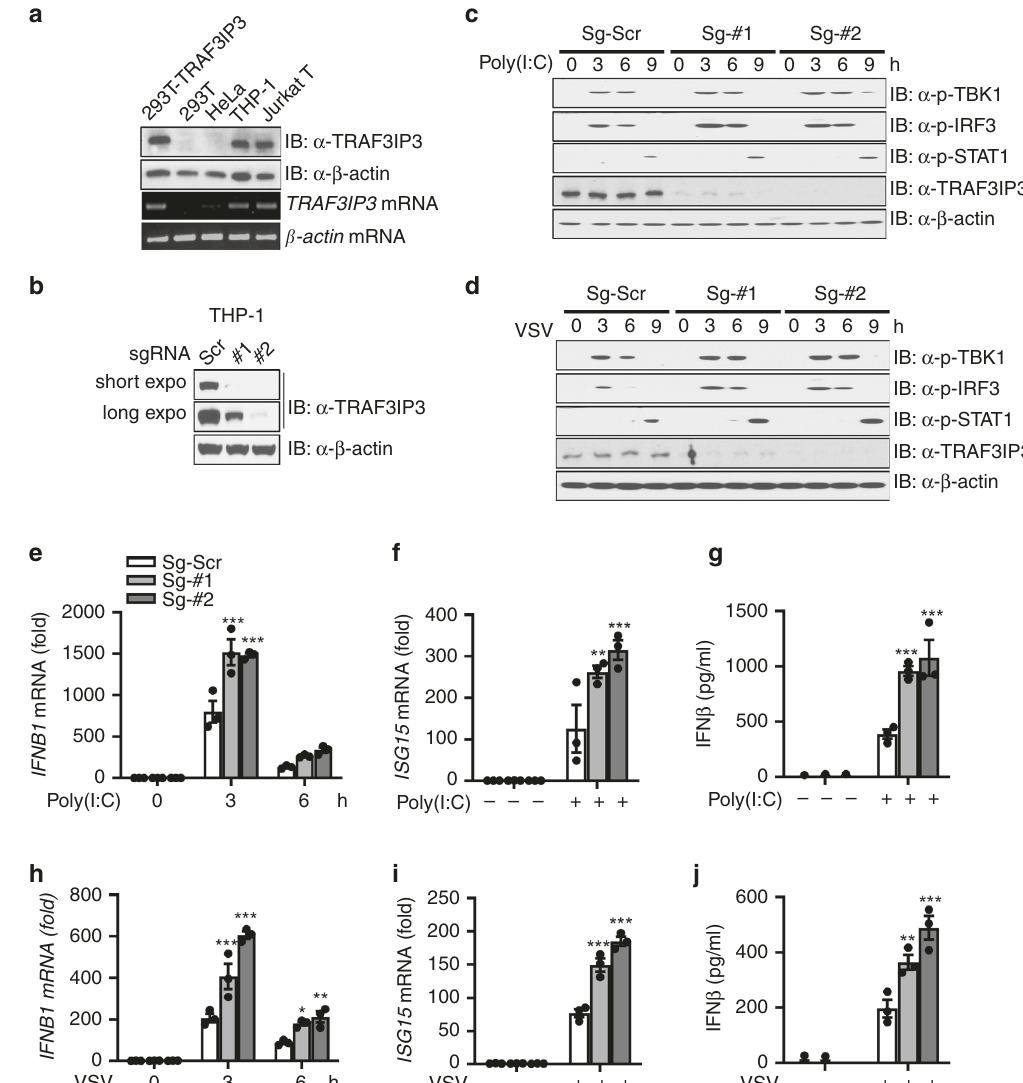
Fig. 2 CRISPR/Cas9 knockout of TRAF3IP3 potentiates the type I interferon response. a Immunoblotting (top) and RT-PCR (bottom) analyses using indicated cell lines. HEK293T cells transfected with Myc-TRAF3IP3 serves as the positive control. b Immunoblotting of THP-1 cells with scramble sgRNA or sgRNA targeting TRAF3IP3 using CRISPR/Cas9. c , d Immunoblotting of THP-1 cells with scramble sgRNA or sgRNA targeting TRAF3IP3 transfected with poly(I:C) ( c ) or infected with VSV (MOI = 1) ( d ) for the indicated time. Densitometry of immunoblots in this Figure is shown in Fig. S4. e , f RT-PCR analysis and g IFN- β ELISA using THP-1 cells with scramble sgRNA or sgRNA targeting TRAF3IP3 transfected with poly(I:C). RT-PCR data were normalized to ACTB mRNA. h , i RT-PCR analysis and j IFN- β ELISA using THP-1 cells with scramble sgRNA or sgRNA targeting TRAF3IP3 infected with VSV (MOI = 1). RT-PCR data were normalized to ACTB mRNA. f , g , i and j were at 9 h post transfection or infection. sgRNA, small guide RNA. Scr, Scramble. Data are presented as mean ± SEM and are one representative of three independent experiments. e – j , two-way ANOVA followed by Holm-Sidak post hoc correction. ∗ p < 0.05, ∗∗